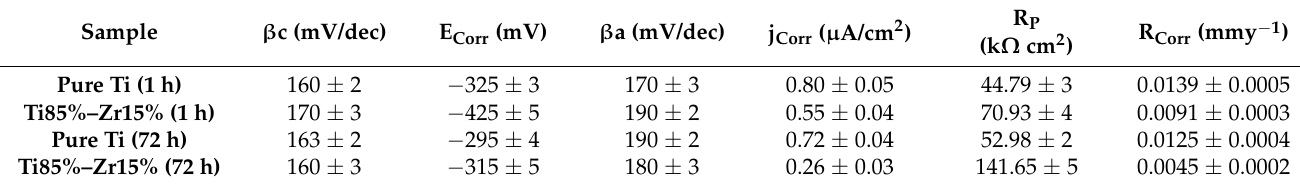
Figure 3. PCP curves for (1) Ti and (2) Ti85-Zr15 after 72 h exposure SBF. Table 1. Corrosion parameters obtained from polarization